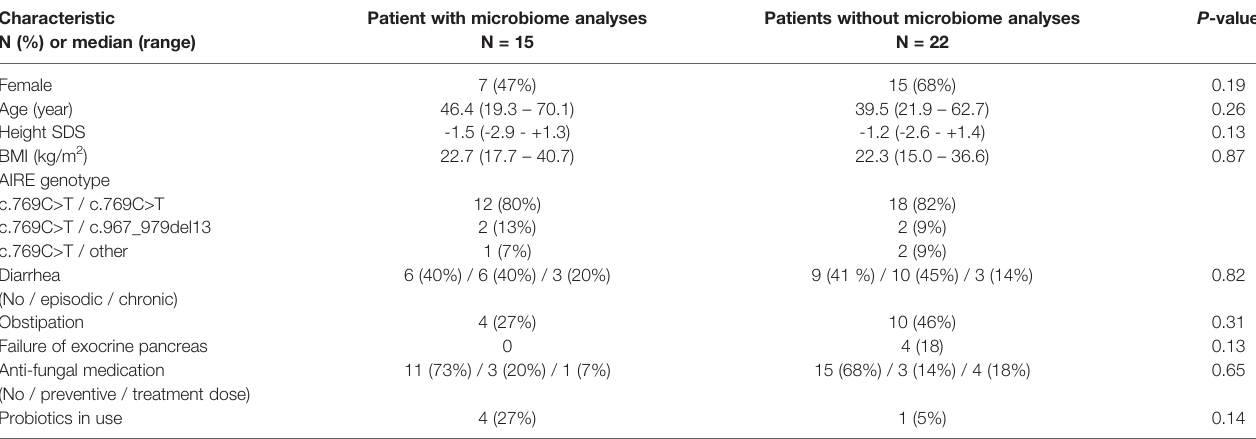
TABLE 1 | Clinical characteristics of the 15 adult patients with APECED included in the present study.